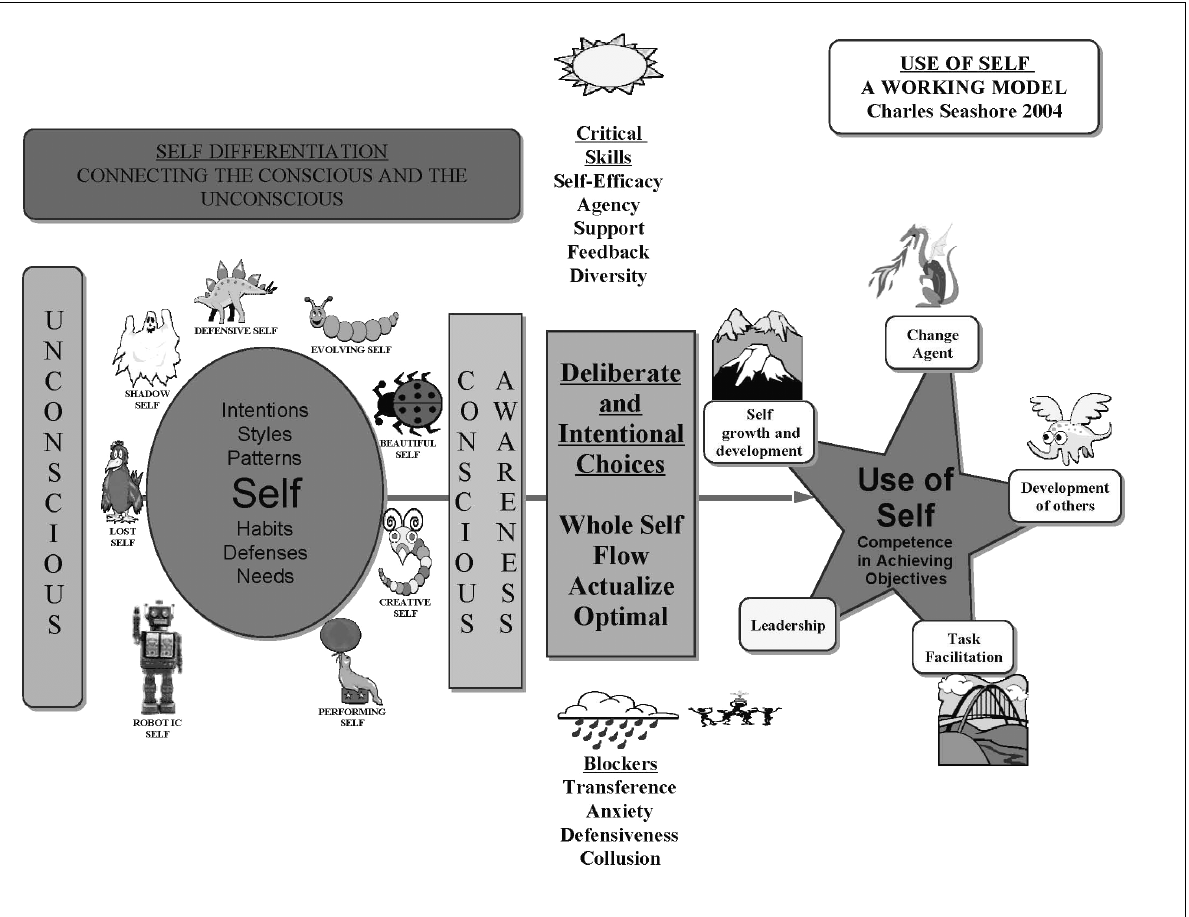
Figure 1. Seashore Model of Use of